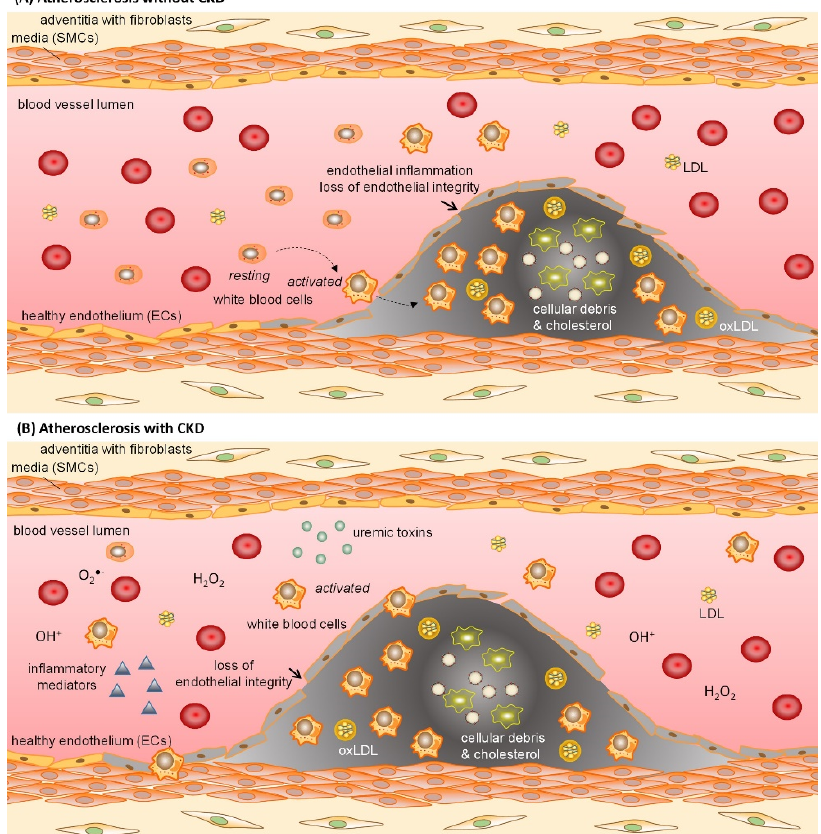
Figure 1. Endothelial inflammation and loss of endothelial integrity contribute to endothelial dysfunction and the formation of atherosclerotic lesions in the vessel wall. Atherosclerosis is characterized by endothelial inflammation and an increased vascular permeability. Inflamed endothelial cells secrete chemokines that recruit white blood cells, which migrate through the dysfunctional endothelial barrier into the vessel wall. Moreover, LDL migrates into the vessel wall where it is oxidized to oxLDL ( A ). In patients with CKD, the process of atherosclerotic lesion formation is advanced because of CKD-associated factors such as systemic chronic low-grade inflammation, increased markers of oxidative stress and lipoprotein oxidation, as well as the accumulation of uremic toxins, all promoting damage to the vessel wall ( B ). ECs = endothelial cells; LDL = low density lipoprotein; oxLDL = oxidized LDL; SMCs = smooth muscle